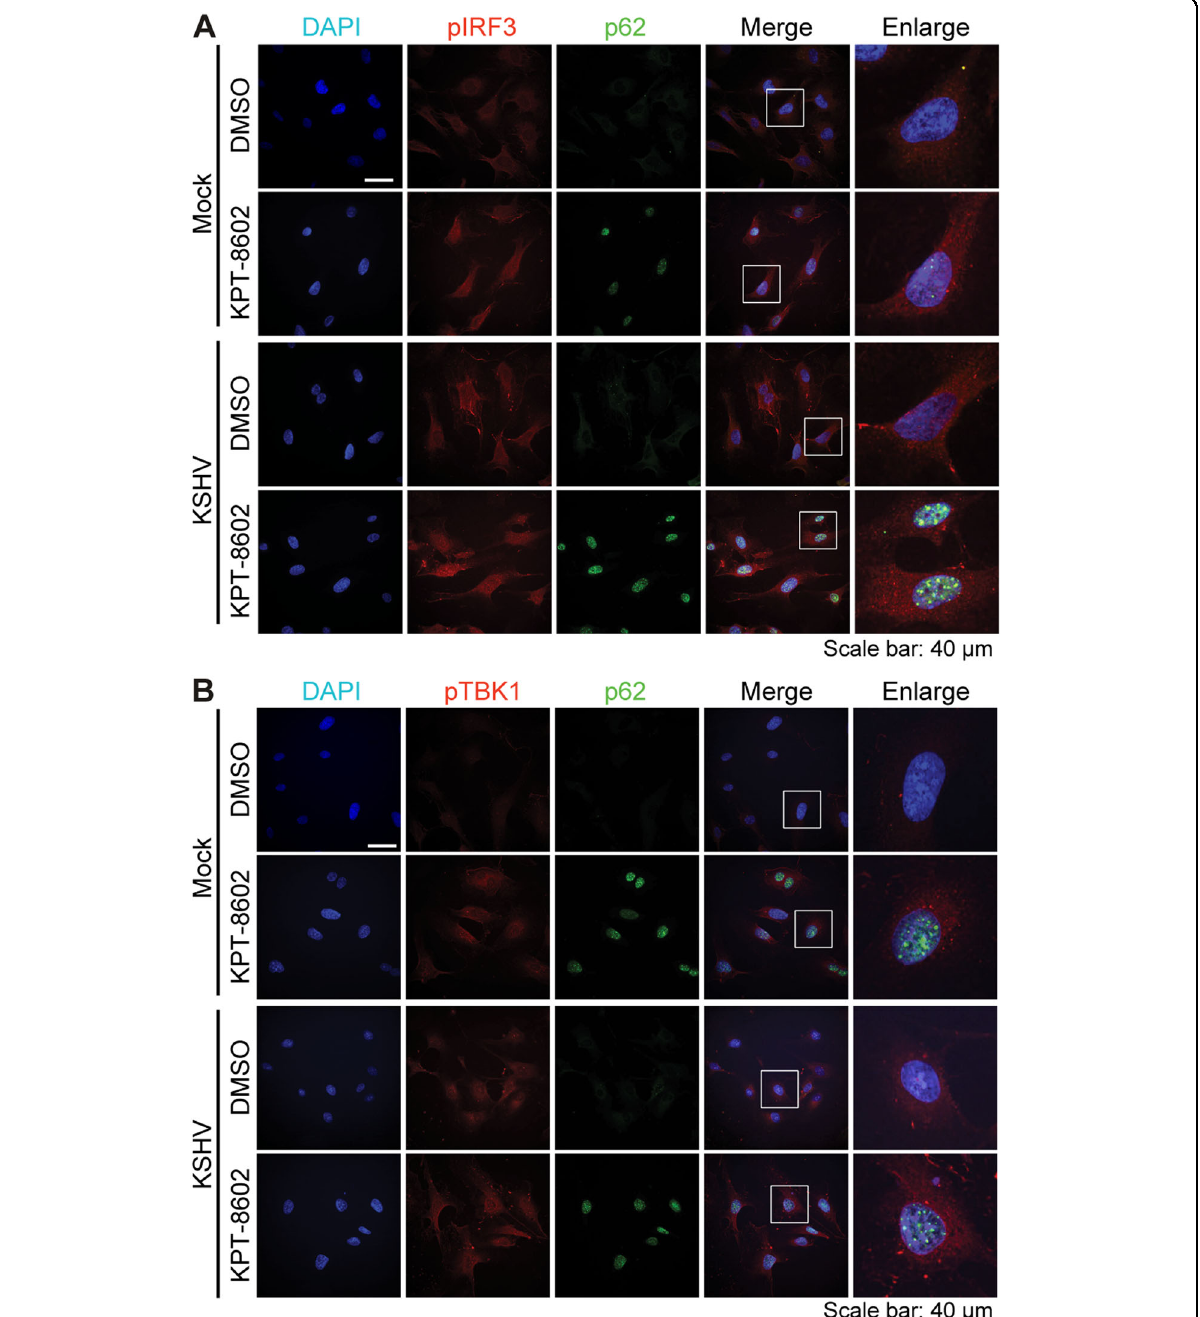
Fig. 4 Treatment with XPO1 inhibitor KPT-8602 induces p62 nuclear retention and enhances IRF3 and TBK1 activation. A , B HUVEC were pretreated with KPT-8602 at 0.5 µM or vehicle control DMSO for 1 h and then infected with KSHV for 12 h in the presence of KPT-8602 or DMSO. Cells were fi xed and co-stained for pIRF3 ( A ) or pTBK1 ( B ) together with p62. Nuclei were stained with DAPI. Images were taken with confocal microscopy (magni fi cation ×600). Magenta p62 was pseudo-colored to green for better